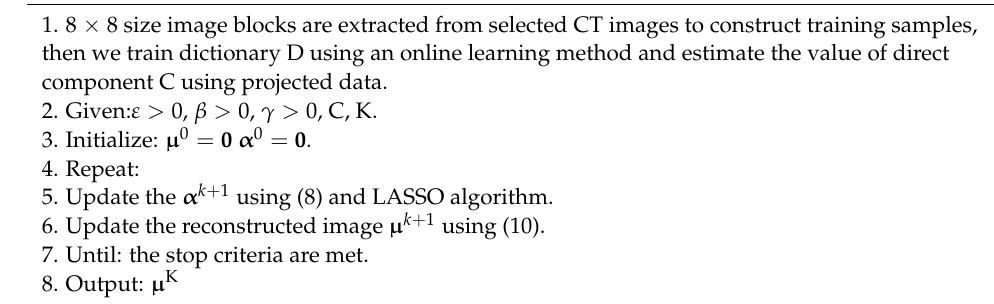
Algorithm 1: The outline of the optimization